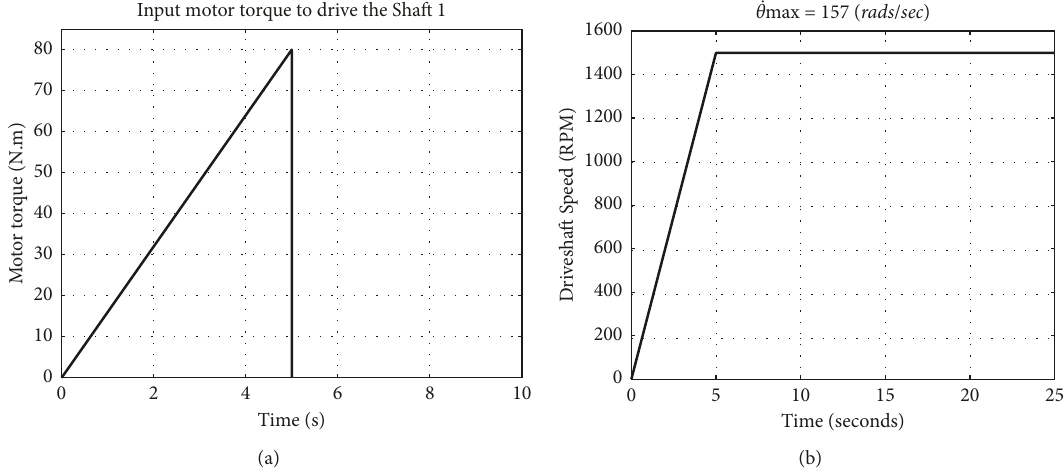
Figure 3: (a) Motor torque maximum speed of 1500rpm. (b) Driveshaft speed profile.